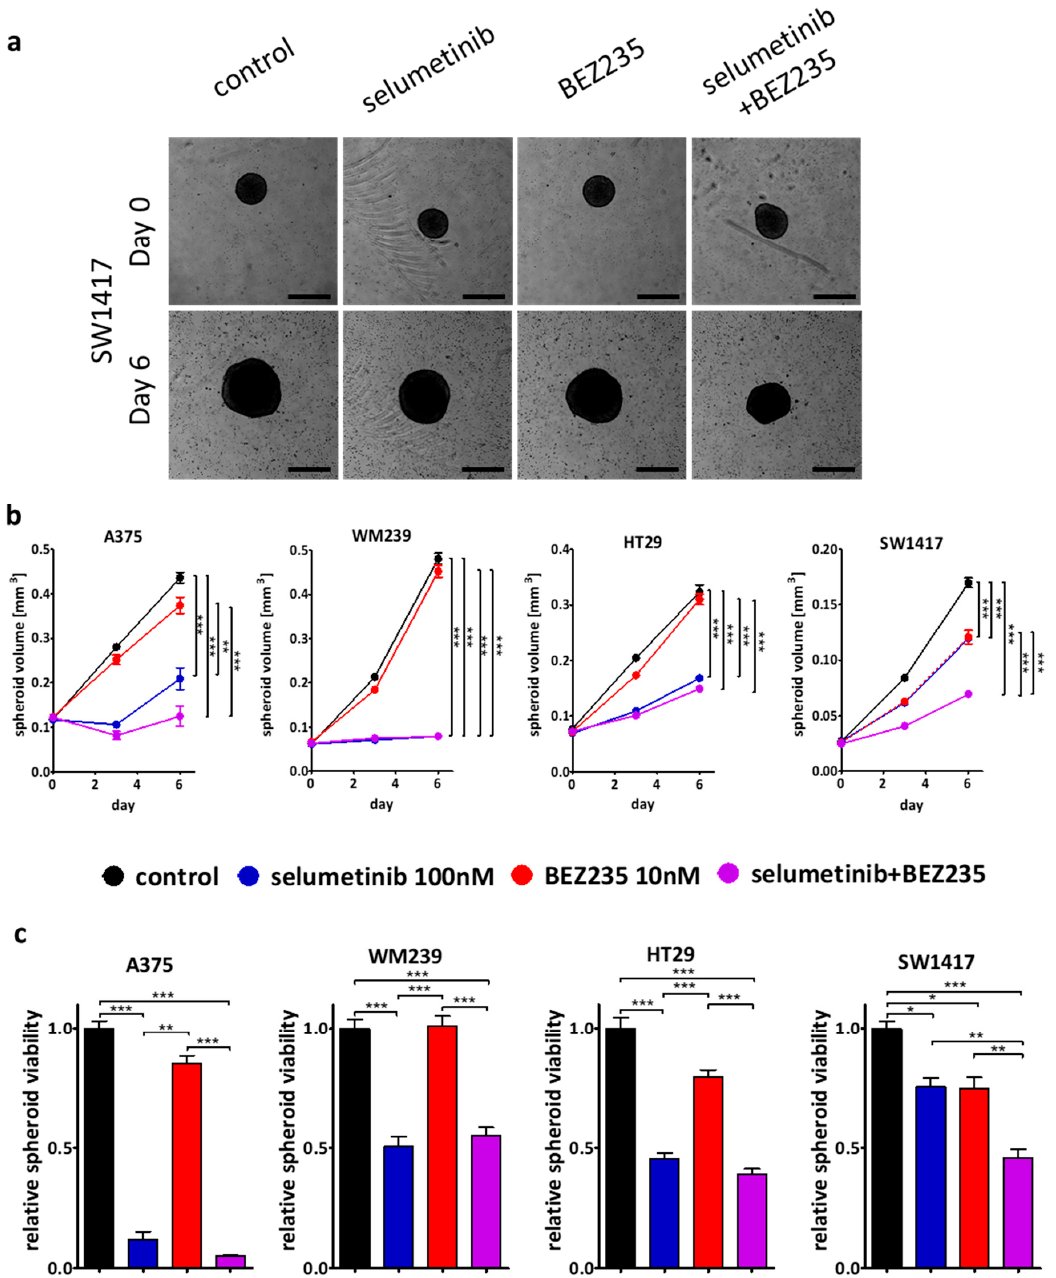
Figure 4. 3D spheroid growth inhibition results upon treatment with single compounds or combination for 6 days. A375, WM239, HT29, and SW1417 cell lines were involved into 3D investigations. ( a ) Representative images of SW1417 spheroids from treatment day 0 and day 6. Scale bar indicate 500 µ m. ( b ) Spheroid volume was detected by taking pictures during the treatment and ( c ) spheroid proliferation by CCK8 at the end of the experiment. Colors indicate the therapy as blue, red means selumetinib, BEZ235 and purple indicates the combination of them, respectively. The combination treatment was significantly more e ff ective than single treatments only in the case of SW1417 spheroids. Data is shown as mean ± SEM from three independent experiments. Asterisks mean a significant di ff erence between the treatment groups by * p < 0.05, ** p < 0.01 and *** p < 0.001.